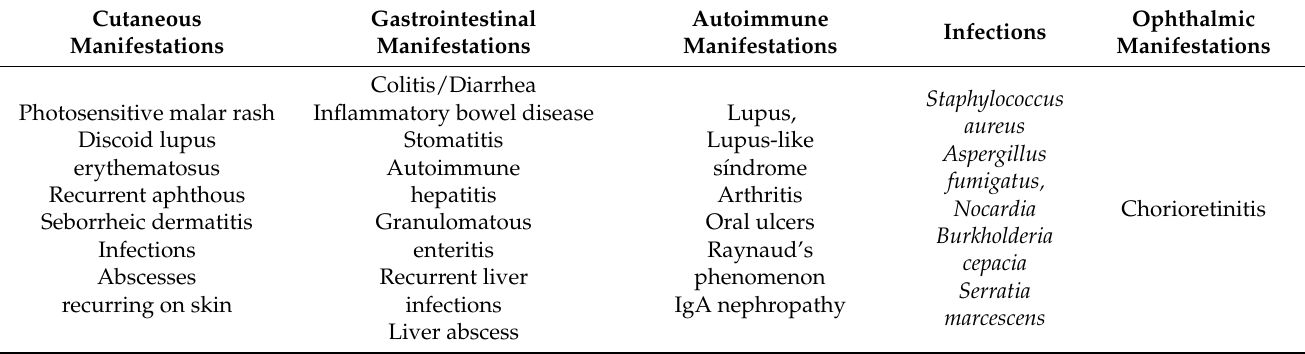
Table 1. Clinical manifestations of